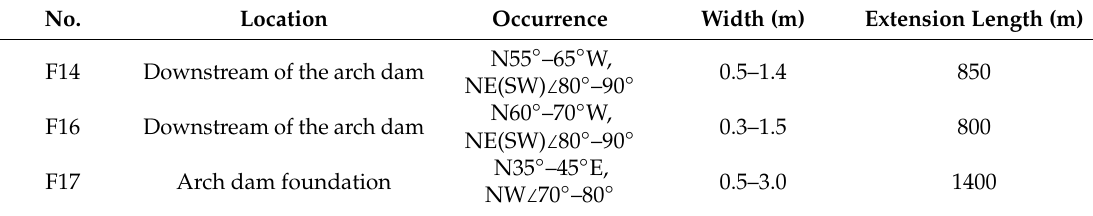
Figure 3. Geological cross-section of the left bank slope along the longitudinal axis of the arch dam after excavation to an elevation of 628 m [26] (Copyright © 2017, Springer Nature). Table 1. Characteristics of the interlayer zones.